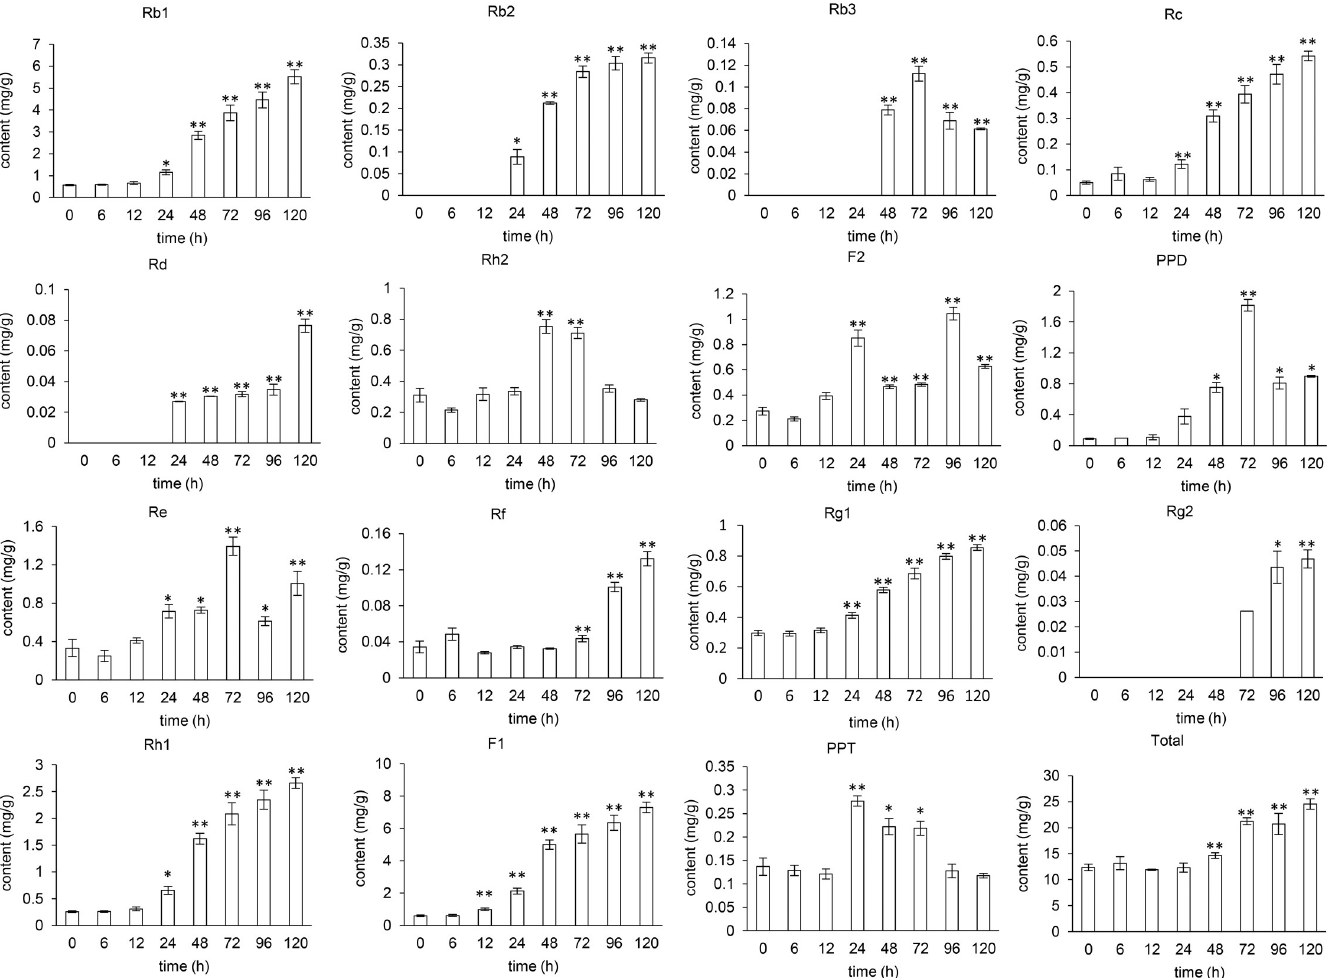
Fig 1. The content of ginsenosides in MeJA-treated ginseng hairy roots. The content of ginsenosides in the samples at “0” h shown in the x-axes of the figures were the average content of ginsenosides in the samples collected at 6 h to 120 h from non-treated culture after MeJA treatment. The t -test was used to determine the difference of ginsenoside content between the MeJA treated samples and the average content of ginsenoside in the non-treated samples. “ � ” for a two-tailed significance of P � 0.05, “ �� ” for a two-tailed significance of P � 0.01.